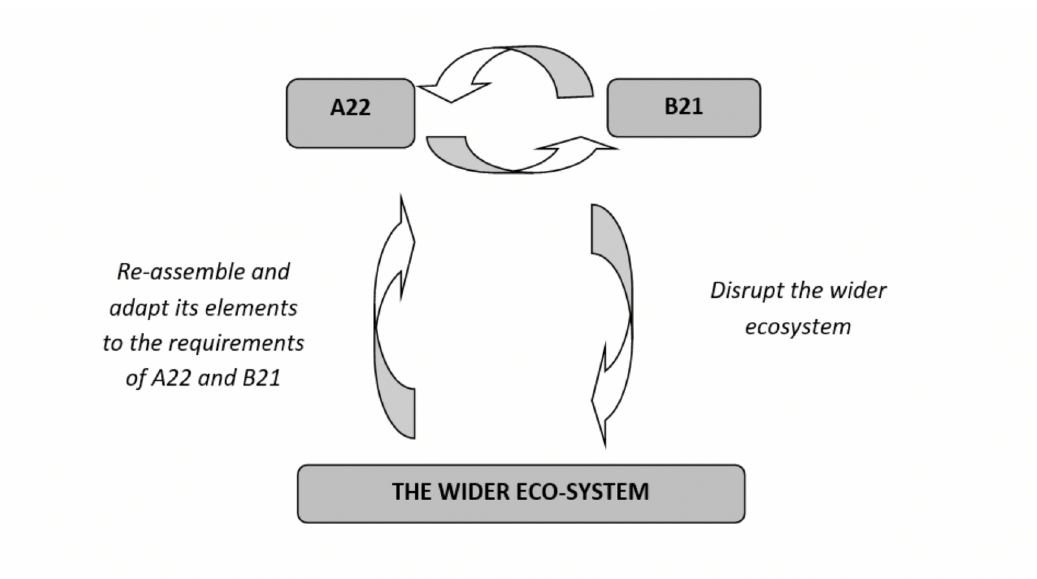
Figure 4. Creative